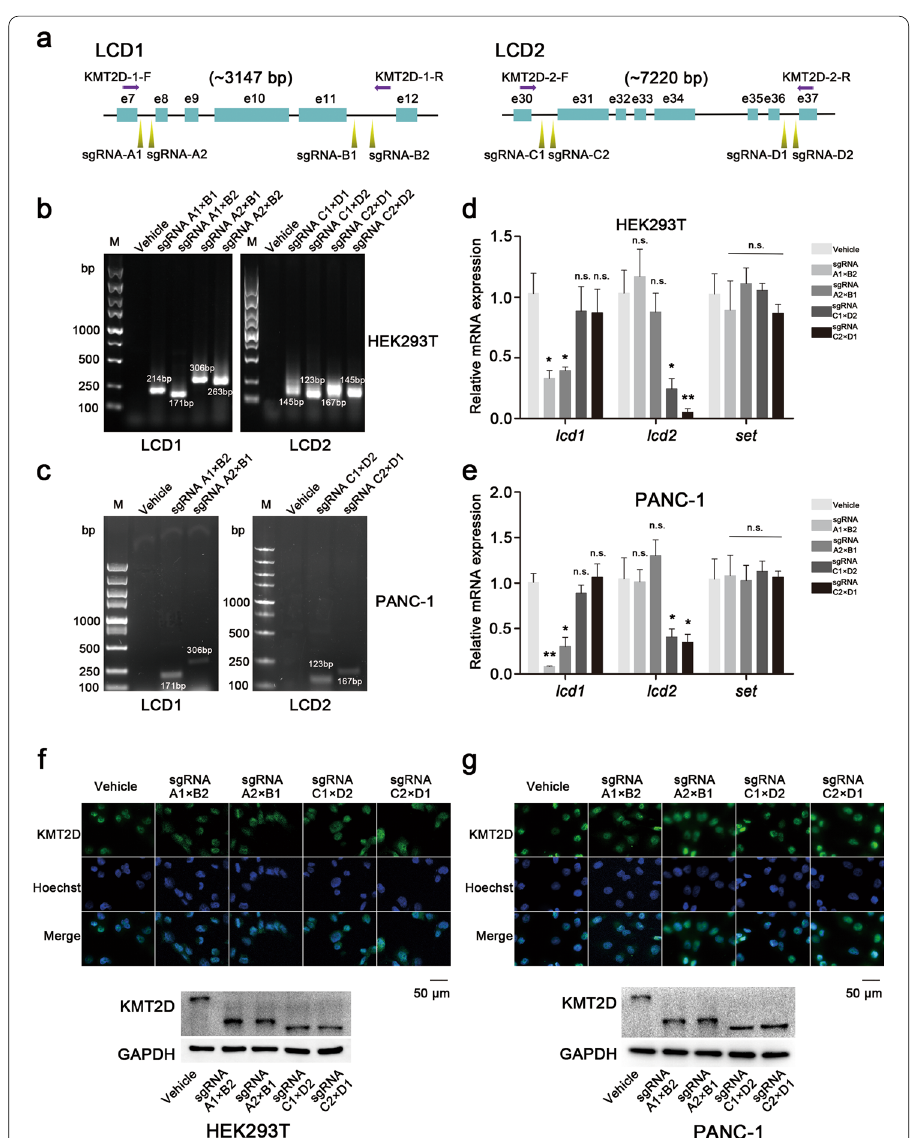
Fig. 2 LCD knockout strategy and verification in HEK293T and PANC-1 cells. a Schematic representation of LCD knockout strategy using CRSPR-Cas9 technology. LCD1 (located between exon 8 and 11) was deleted with sgRNA primers: two upstream primers (sgRNA-A1/A2) and two downstream primers (sgRNA-B1/B2). This was then verified by genotyping with KMT2D-1-F/R primers. For LCD2 (located between exon 31 and 36), two upstream primers (sgRNA-C1/C2) and two downstream primers (sgRNA-D1/D2) were used to delete LCD2 and then the rest was tested with KMT2D-2-F/R primers. b , c Verification with genotyping assays. In HEK293T and PANC-1 cells, genotyping PCR was performed in transfected cells. The results are consistent with the predictions compared with the control group (vehicle). d , e RT-PCR analyses to measure LCD knockout. lcd1 mRNA expression only significantly decreased in LCD1-deleted cells, while that of lcd2 only in LCD2-deleted cells. The set gene located at the C-terminal of the KMT2D gene was selected as a control (error bars denote standard deviation). f , g Representative images of immunofluorescences and western blotting in HEK293T and PANC-1 cells. After LCD knockout, the KMT2D protein level did not significantly decrease, and KMT2D LCD1 or KMT2D LCD2 was successfully deleted. KMT2D, 593 KDa; LCD1 deletion-KMT2D, 483 KDa; LCD2 deletion-KMT2D, 447 KDa. All the values are represented as means SD. Data are representative of three ± independent